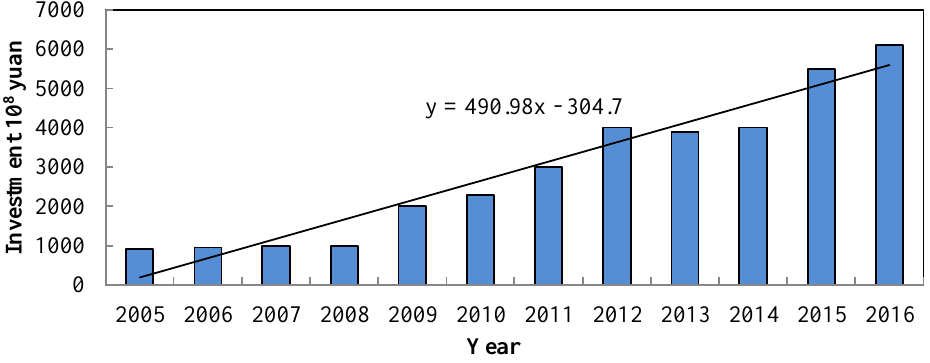
Figure 4. Investment in water infrastructure. Date source: Statistic Bulletin on China Water Activities.